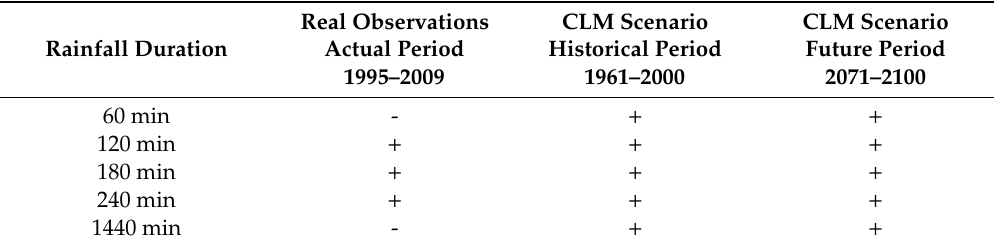
Figure 8. Burn´s diagram for a rainfall duration of one day at the Liptovská Tepli č ka and Vyšná Boca climatological stations. Table 5. Trend analysis of short-term rainfall intensities for the Liptovská Tepli č ka climatological station—Boca River basin.